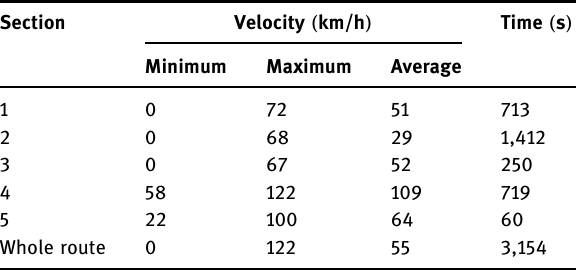
Figure 8: Longitudinal accelerations – afternoon